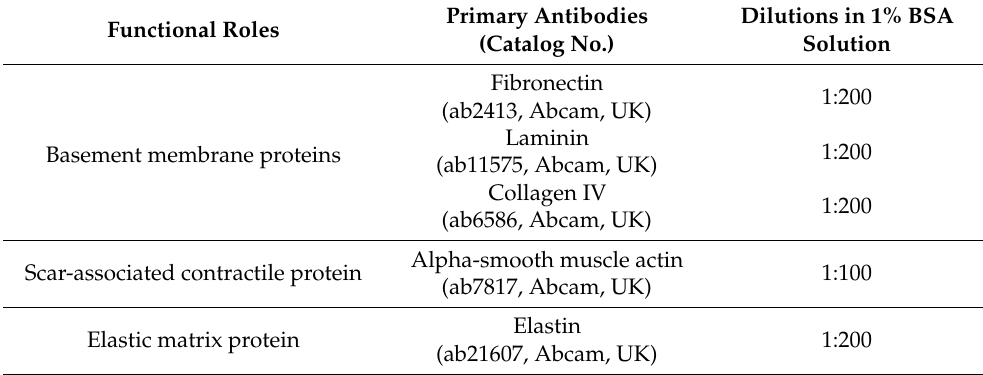
Table 2. List of primary antibodies to extracellular matrix proteins involved in wound healing. Functional